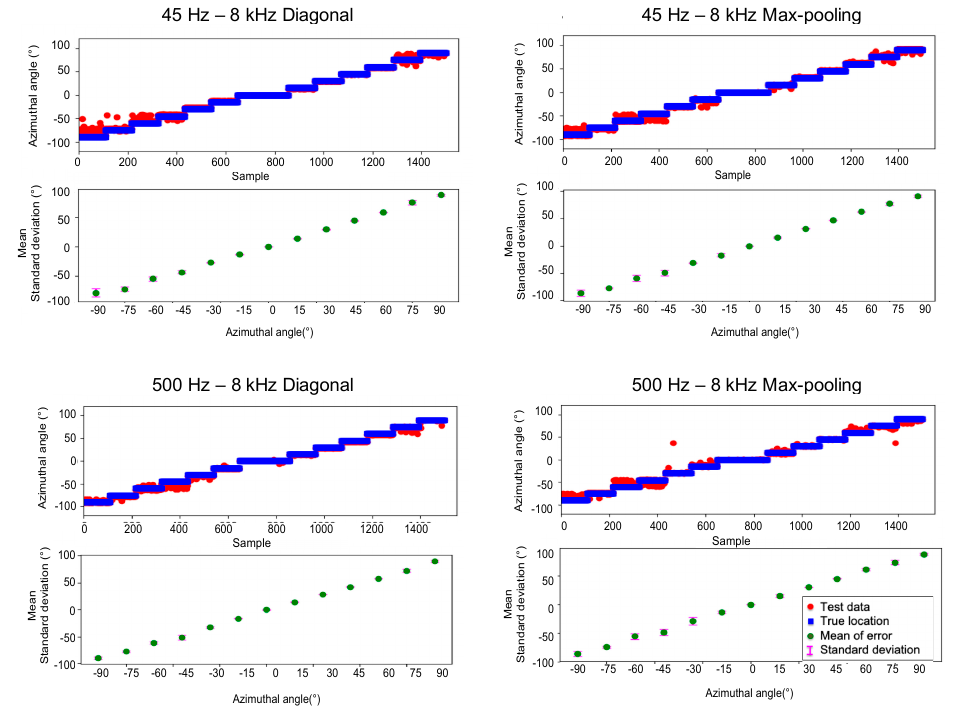
Instantaneous cross correlation with two silicon cochlear models on chip Propose FPGA implementation of the cochlear model, LIF neuron model and Three-chip system; One for onset detection, one for BPF bank and IED/IID cue extraction, and one for cross-correlation,